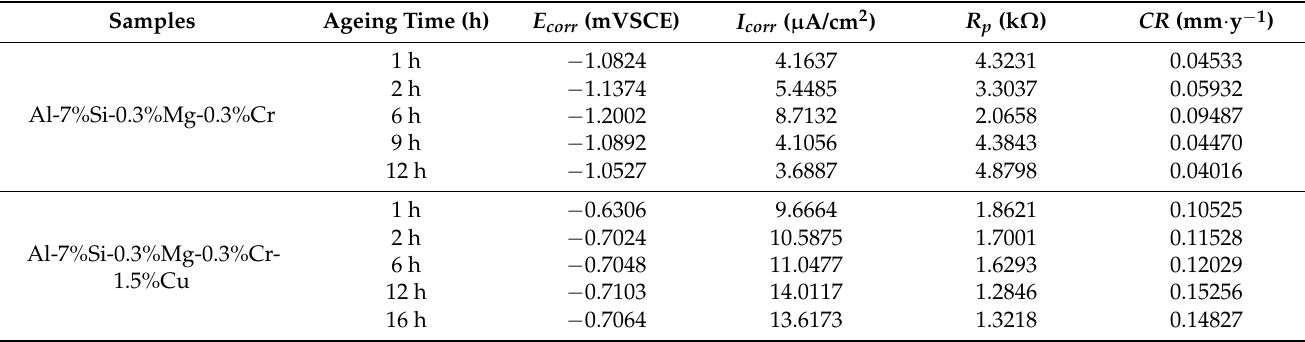
Table 2. Tafel polarization data for Al-7%Si-0.3%Mg-0.3%Cr alloy and Al-7%Si-0.3%Mg-0.3%Cr- 1.5%Cu alloy.